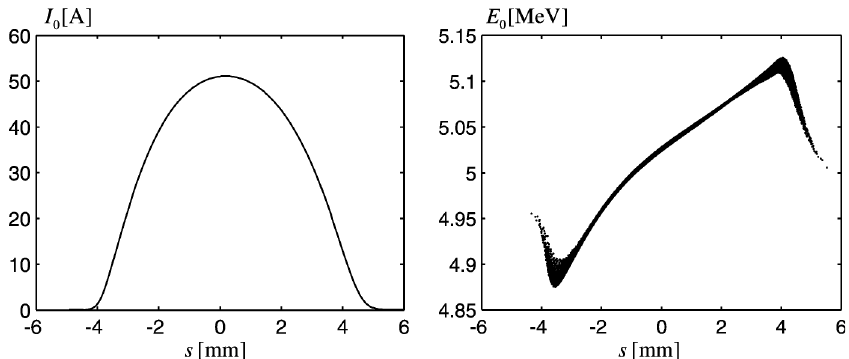
FIG. 1. The initial particle distribution after the rf gun. The left plot shows the current profile. The right plot presents the longitudinal phase